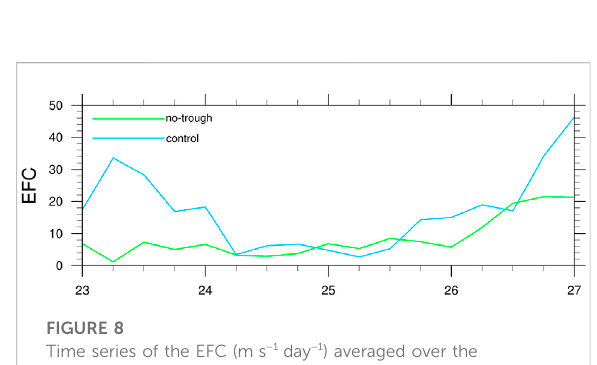
FIGURE 8 Time series of the EFC (m s − 1 day − 1 ) averaged over the annulus between the radii of 300 – 600 km at 200